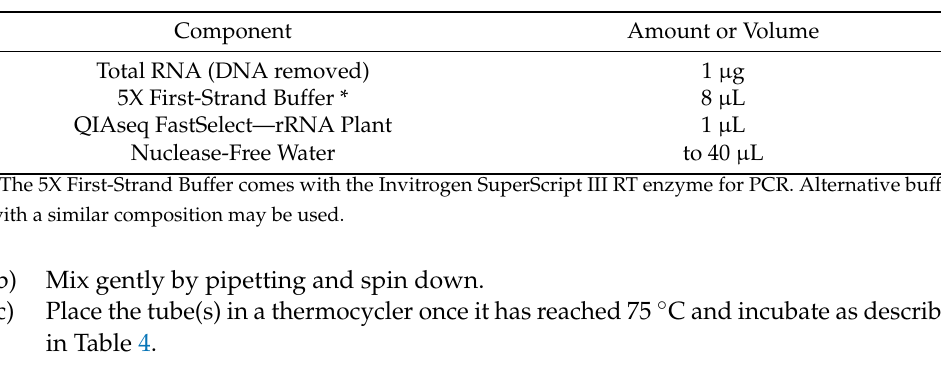
Table 3. Host ribodepletion reaction